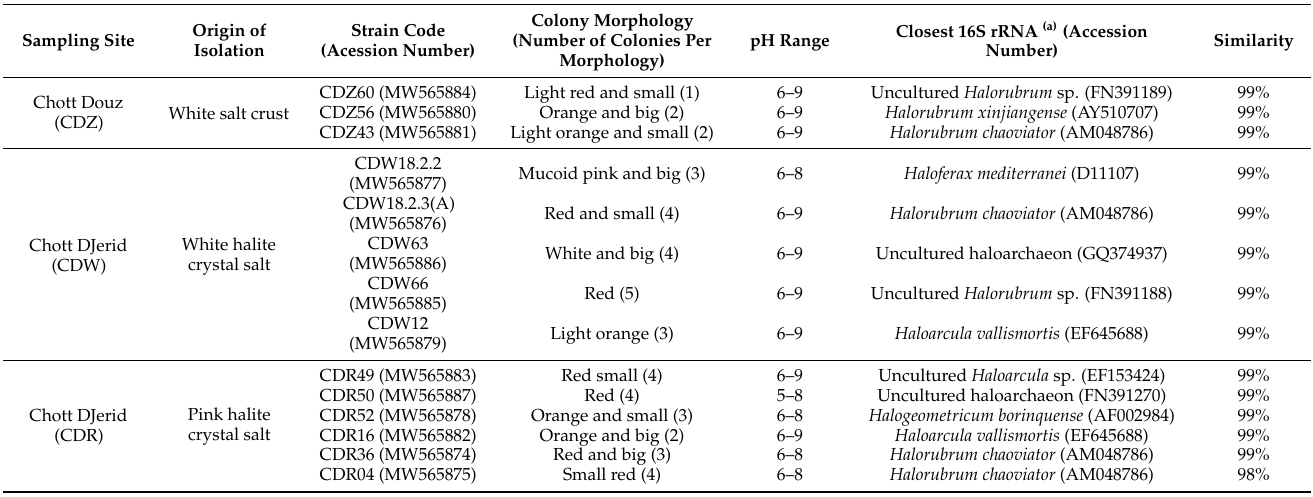
Table 1. Morphological and molecular characterization of colonies isolated from three halite-crystal samples—namely CDW, CDR, and CDZ Sampling Site Origin of